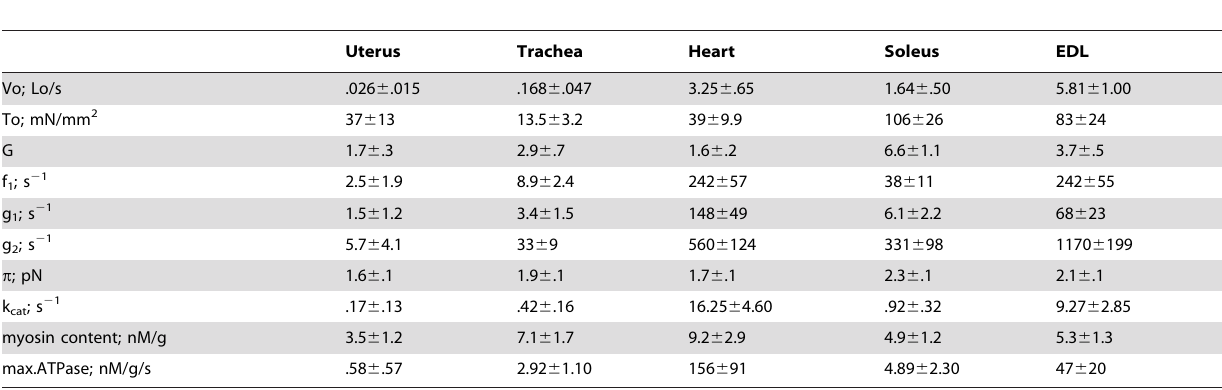
Table 2. Mechanical parameters of smooth and skeletal muscles and CB characteristics previously published in the literature [19,22,23].